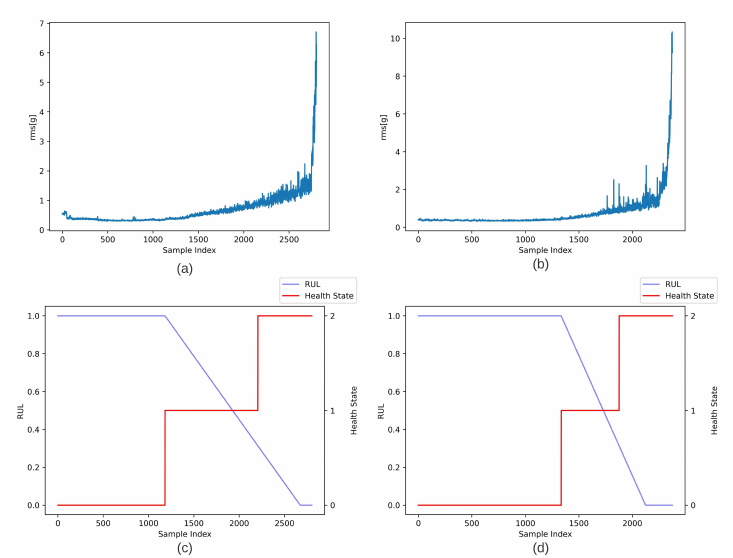
Figure 9. ( a , b ) RMS of each samples of dataset 1_1 and 1_3; ( c , d ) RUL and health state of dataset 1_1 and